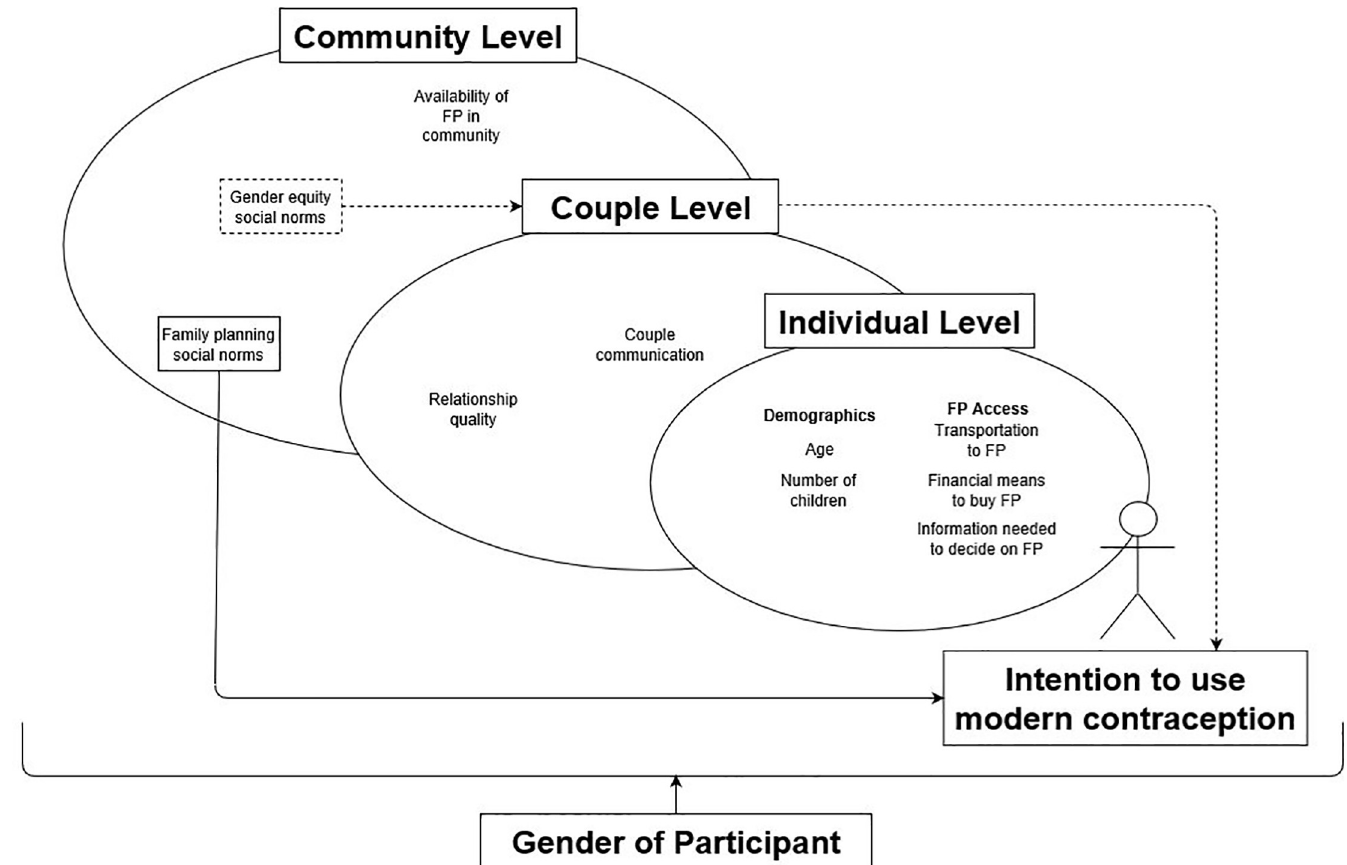
Fig 1. Conceptual model of factors theorized to affect use of modern contraception in Kinshasa, DRC.